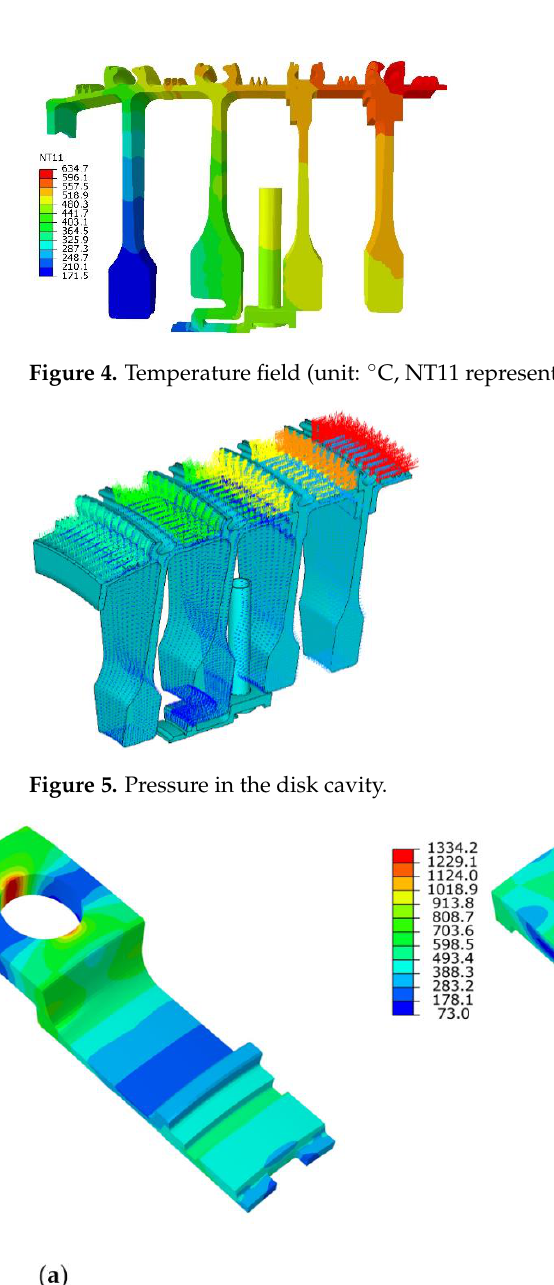
Table 1. Chemical composition of high-strength GH4169 alloy.